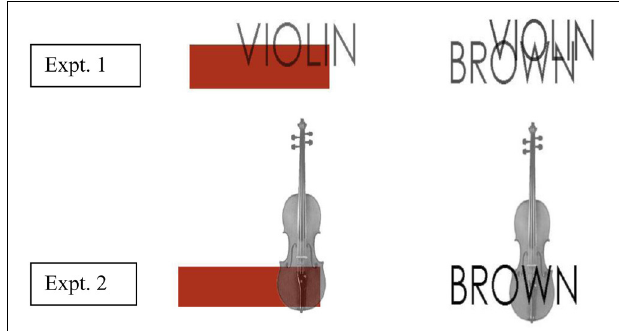
FIGURE 2 | Examples of object and color format conditions in the lexical-semantic matching task for violin . The test conditions